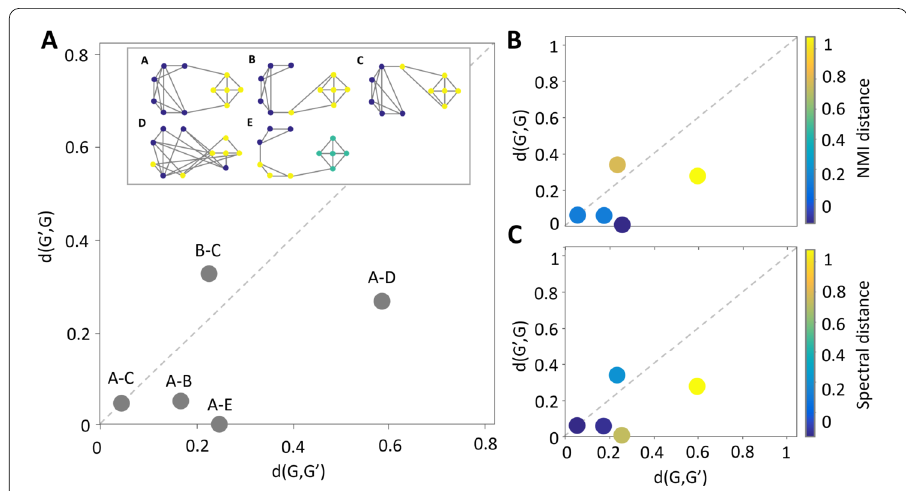
Figure 2 Using the same networks as Fig. 1 (shown in the inset of subfigure ( A )), we compare the same pairs using the BiDir distance, shown in ( A ). We notice that distance between the pair A–C is small, as demonstrated by a BiDir value very close to the origin and identity line. Similarly, if we project the communities of A onto network E, we obtain a very good fit and a near zero distance (as shown by the point on the x axis). This is a consequence of the fact that the communities of E are a refinement of the ones in A. This does not hold true in the other direction, i.e., if we project the communities of E onto A, as shown by a non-zero distance of the point to the y axis. On the right, in ( B ) and ( C ), we can see how rankings derived from other metrics, such as NMI and spectral distance, do not fully capture these features. For NMI, the A–E pair is similar, but not so for the spectral